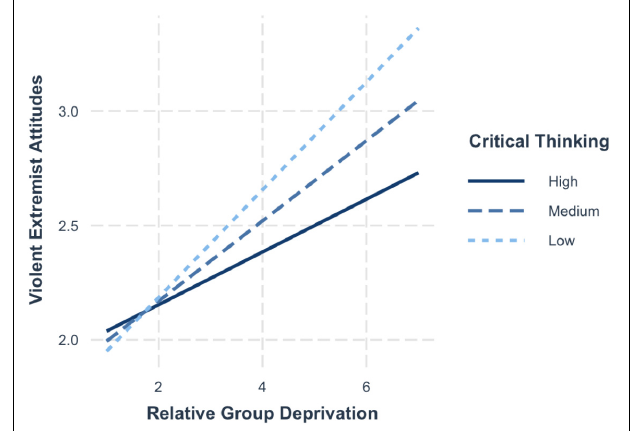
FIGURE 6 | Simple slopes for group deprivation and self-control on violent extremist attitudes.